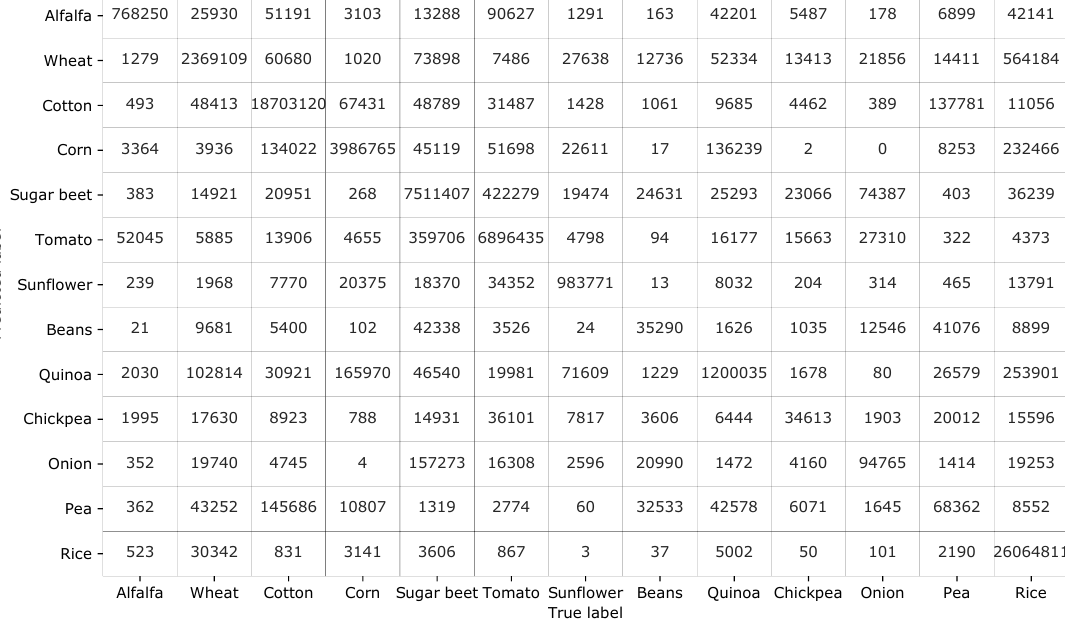
Figure 7. Confusion matrix for the set of 7 features at HH and VV channels at pixel